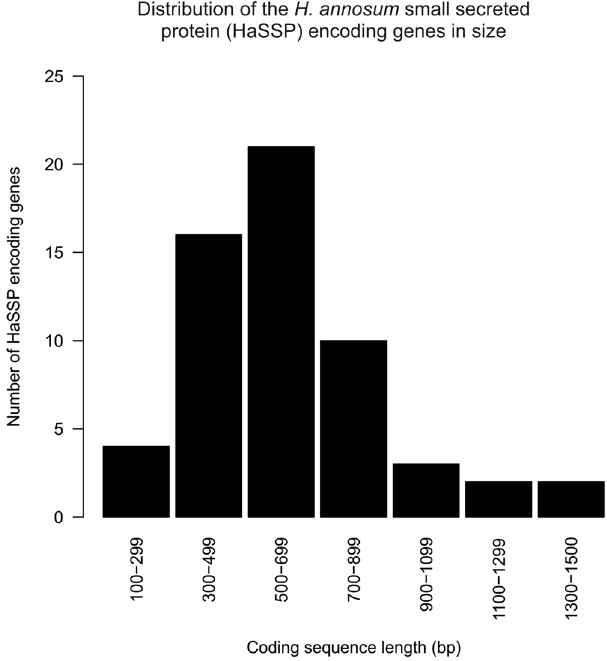
Figure 1. Distribution of the length of the H. annosum small secreted protein (HaSSP) encoding genes as retrieved from the H. annosum TC 32-1 genome